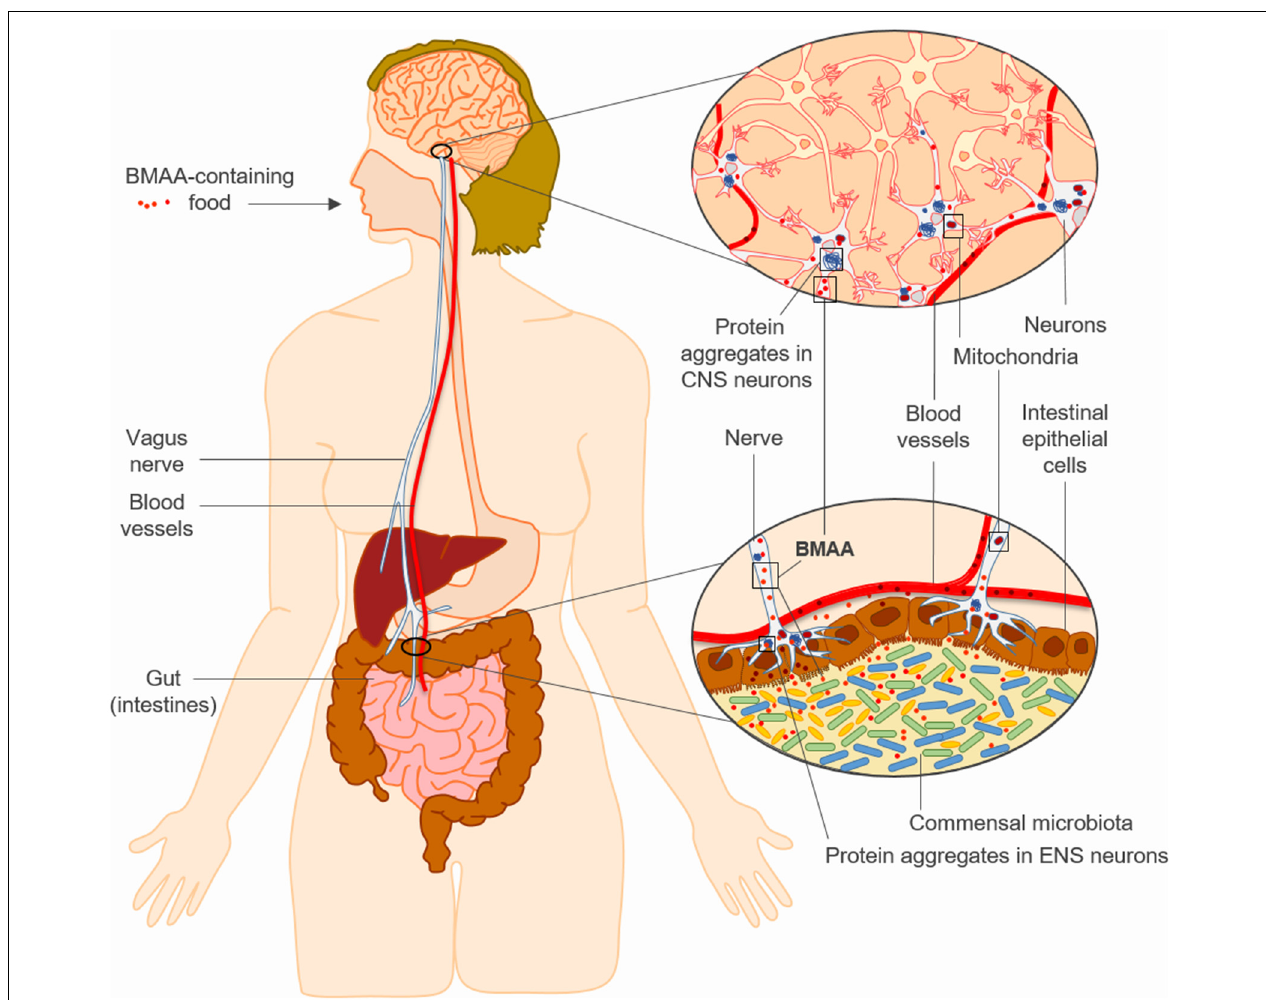
FIGURE 1 | The “neurotoxin hypothesis” for sporadic neurodegenerative diseases such as Parkinson’s disease (PD). Chronic intestinal exposure to β - N -methylamino-L-alanine (BMAA) may trigger neurodegeneration by promoting protein misfolding, mitochondrial dysfunction and innate immune responses in genetically susceptible individuals, initially in the enteric nervous system (ENS) and later in the central nervous system (CNS) through retrograde transport via the vagus